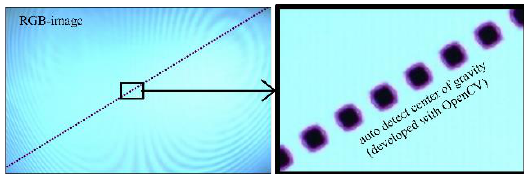
Figure 6. Getting center of calibration points automated with OpenCV.